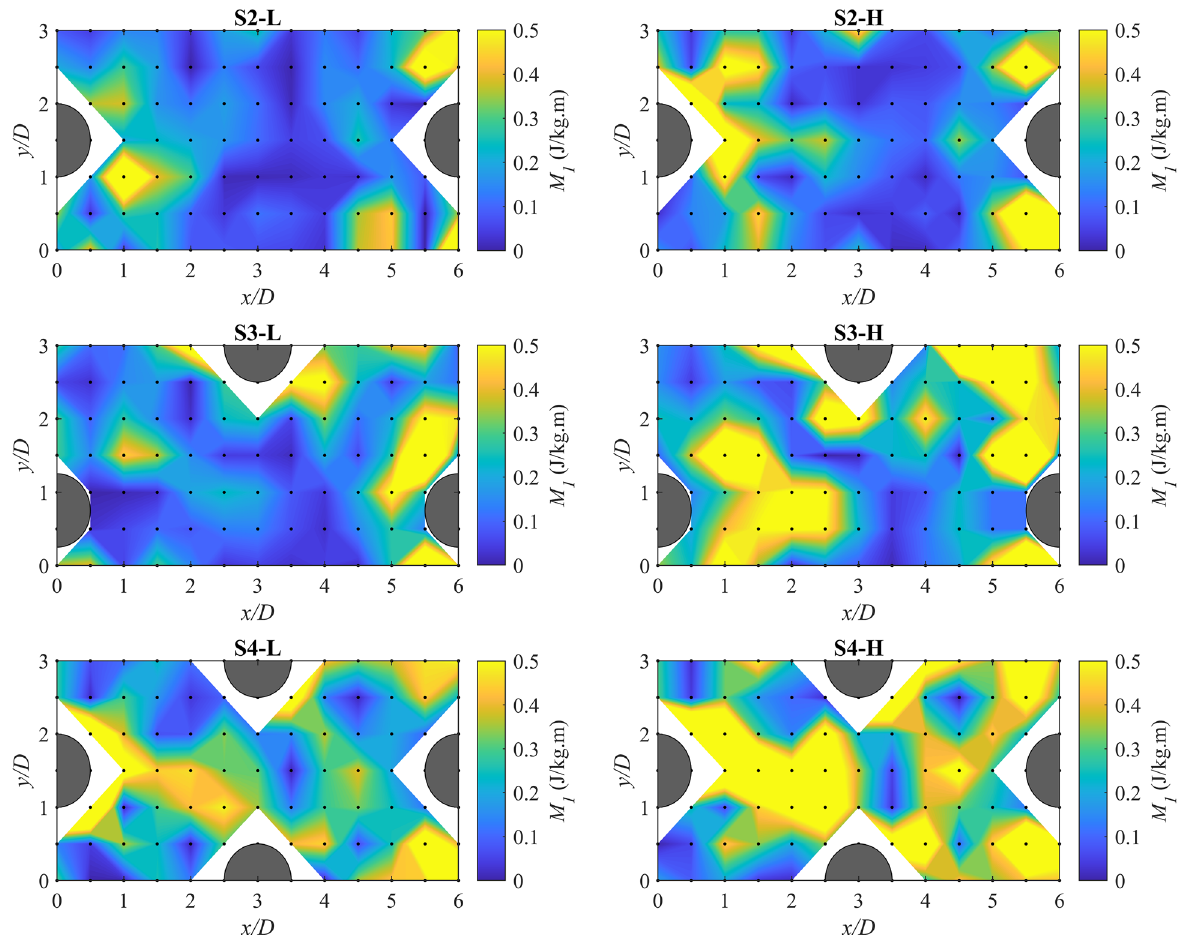
Figure 4. Contour maps of the kinetic energy gradient metric, M 1 , for scenarios with boulder placement in the detailed measurement zone for Δ s = Δ x = 0.06 m. Black dots show the measuring station locations. The blank (white) areas in the contour maps are due to the missing measuring points occupied by